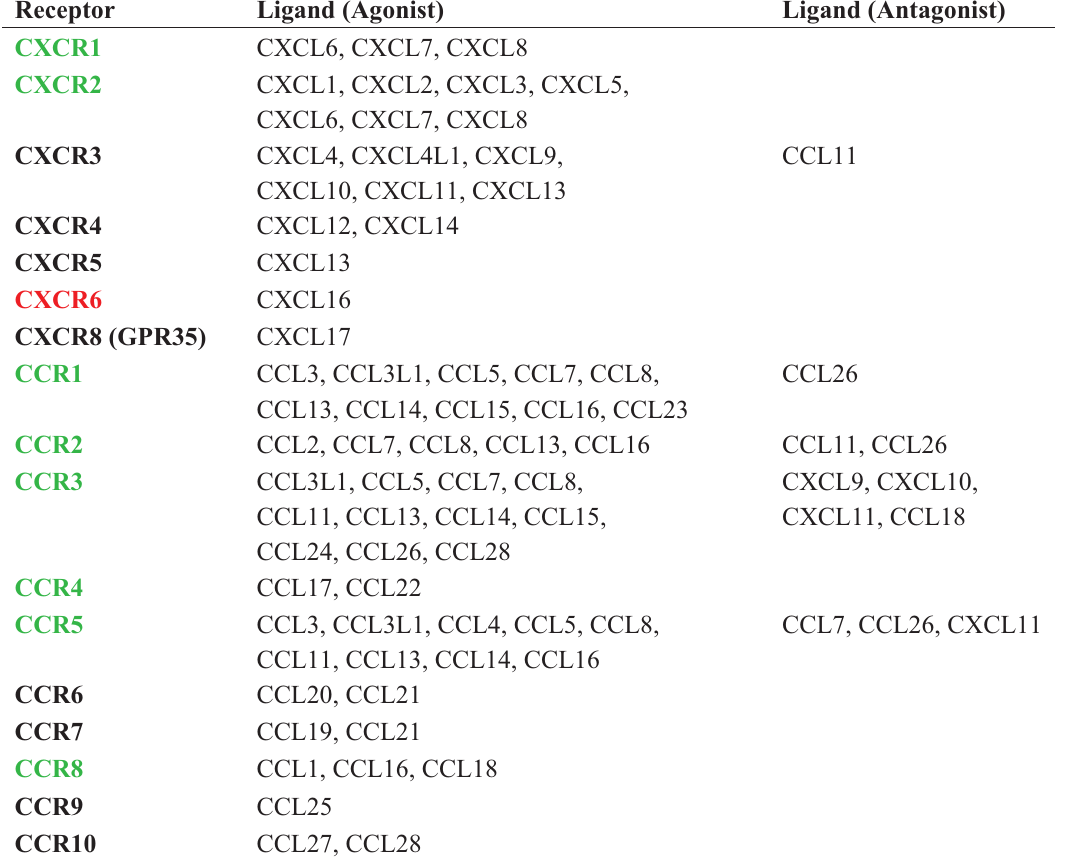
Table 1. Summary of the CXCR, CCR, XCR CXCR and ACKR receptor subfamilies